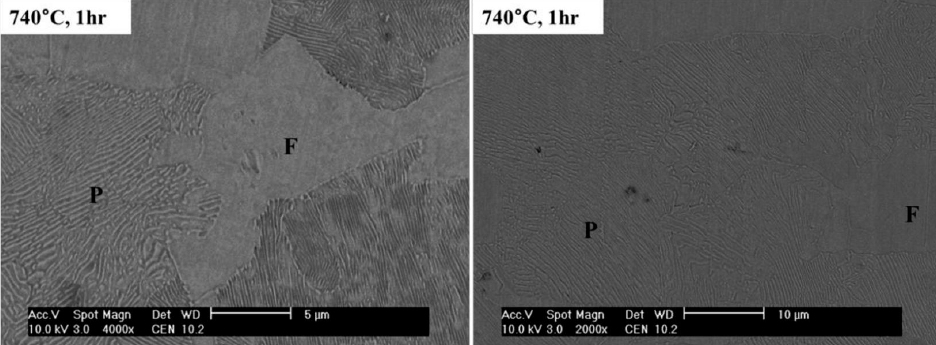
FIG. 5. SEM MICROSTRUCTURE OF SLOWLY HEATED STEEL IN BOX FURNACE AT 74 0 C FOR 1